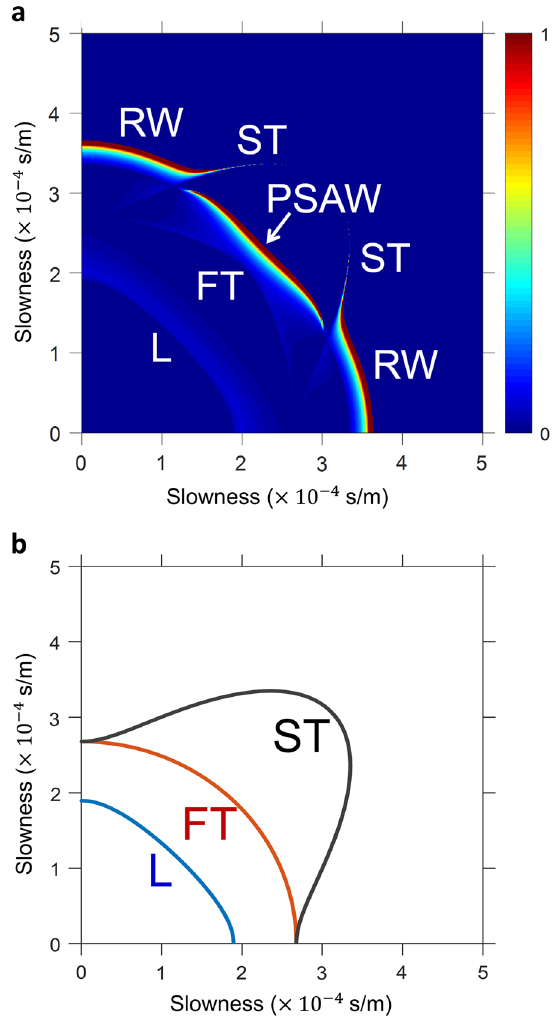
Fig. 1 Computed acoustic wave behavior on the (001) surface of pure Ni plotted in the slowness (reciprocal of velocity) space: a full solution with both surface waves and bulk waves; and b bulk wave solutions only. The fast-acting bulk wave solutions in b for the L, FT, and ST modes help the identi fi cation of the two surface waves: the RW and the PSAW. The color in a shows the relative magnitude of the wave displacement on the